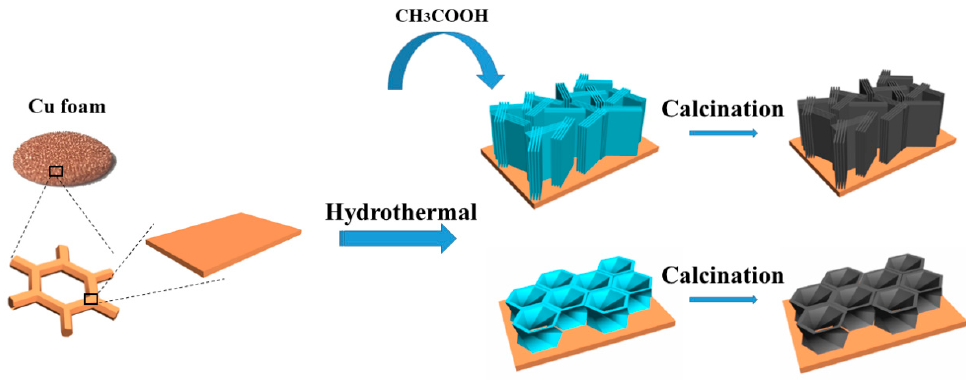
Scheme 1. Schematic illustration of the synthesis process of CoO with two different morphologies on copper foam substrates.